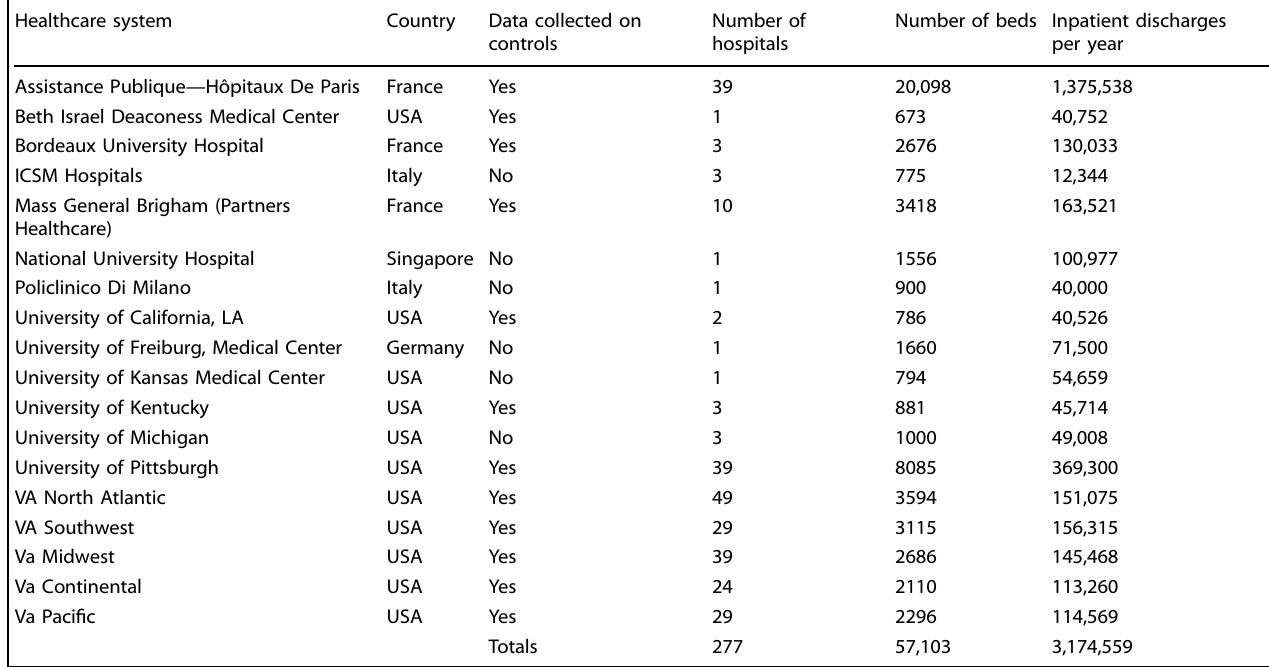
Table 2. Characteristics of participating healthcare